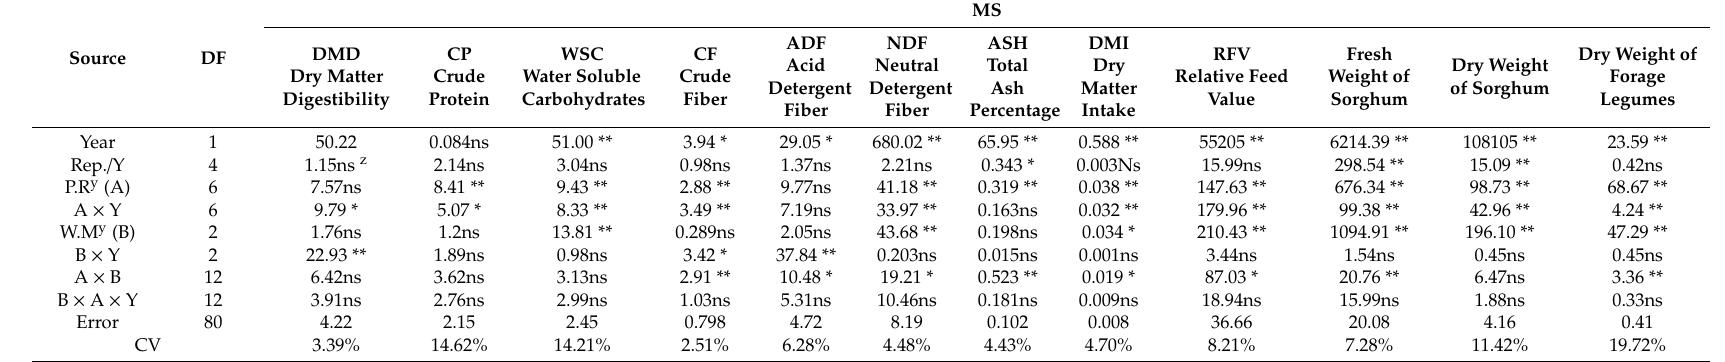
Table 3. Analysis of variance for qualitative traits of sorghum forage under increasing intercropping sorghum cultivation with vetch and lathyrus using combined data from 2015 to